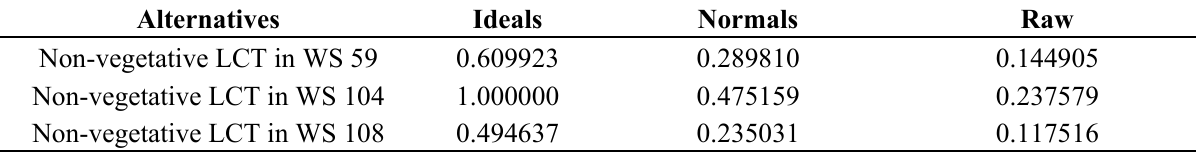
Table 7. The overall synthesized priorities for the candidate rainwater harvesting sites.